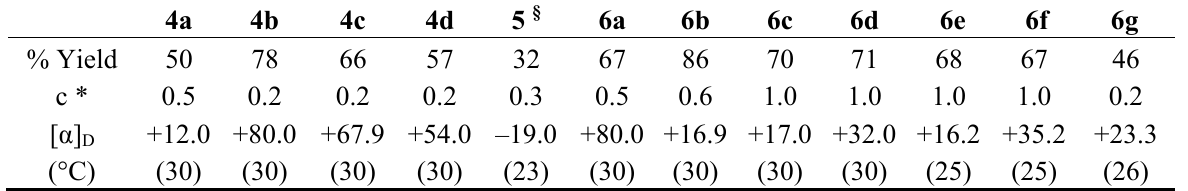
Table 1. The %yield and specific rotations of 4a – d , 5 and 6a – g